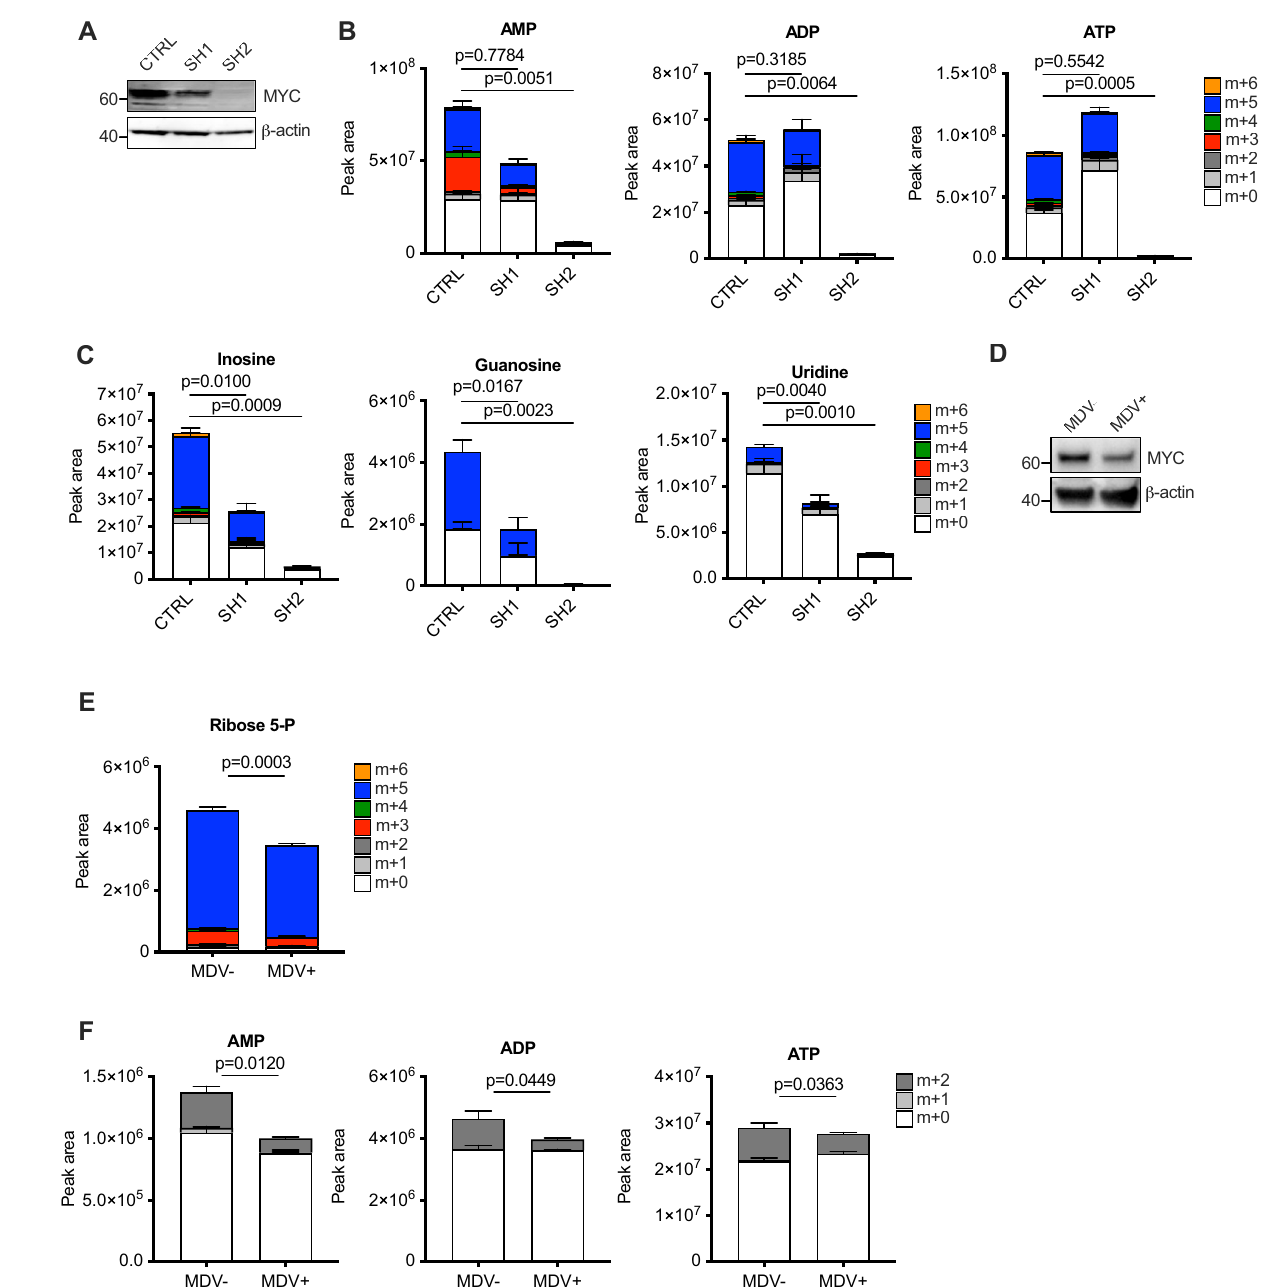
of MYC levels upon 96h enzalutamide (MDV) treatment in Myc-caP cells. E , F Incorporationof( E )Incorporationof 13 C 6 -glucoseintoribose5-phosphatewith a5minpulseand( F ) 15 N-glutamineintoadeninenucleotideswitha6hpulseinMyc- caP cells treated for 48h with enzalutamide (MDV). An ordinary one-way ANOVA was used to determine statistical signi fi cance for the m+5 or m+2 isotopologue for ( E ) and ( F ), respectively ( n =3 biological replicates). For all statistical tests, P ≤ 0.05 was considered signi fi cant and error bars show the standard error of the